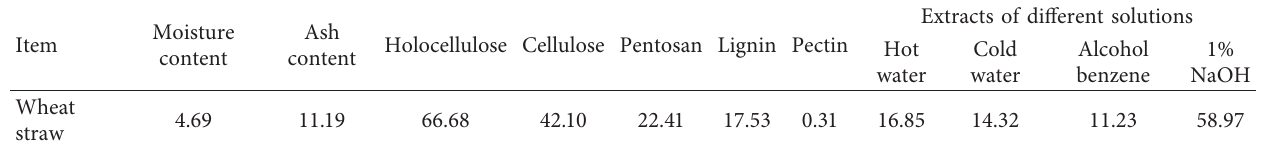
Figure 1: Appearance of wheat straw and wheat straw fiber. (a)Wheat straw. (b) Wheat straw fiber (particle size 0.3mm). Table 2: Chemical composition of wheat straw fibers